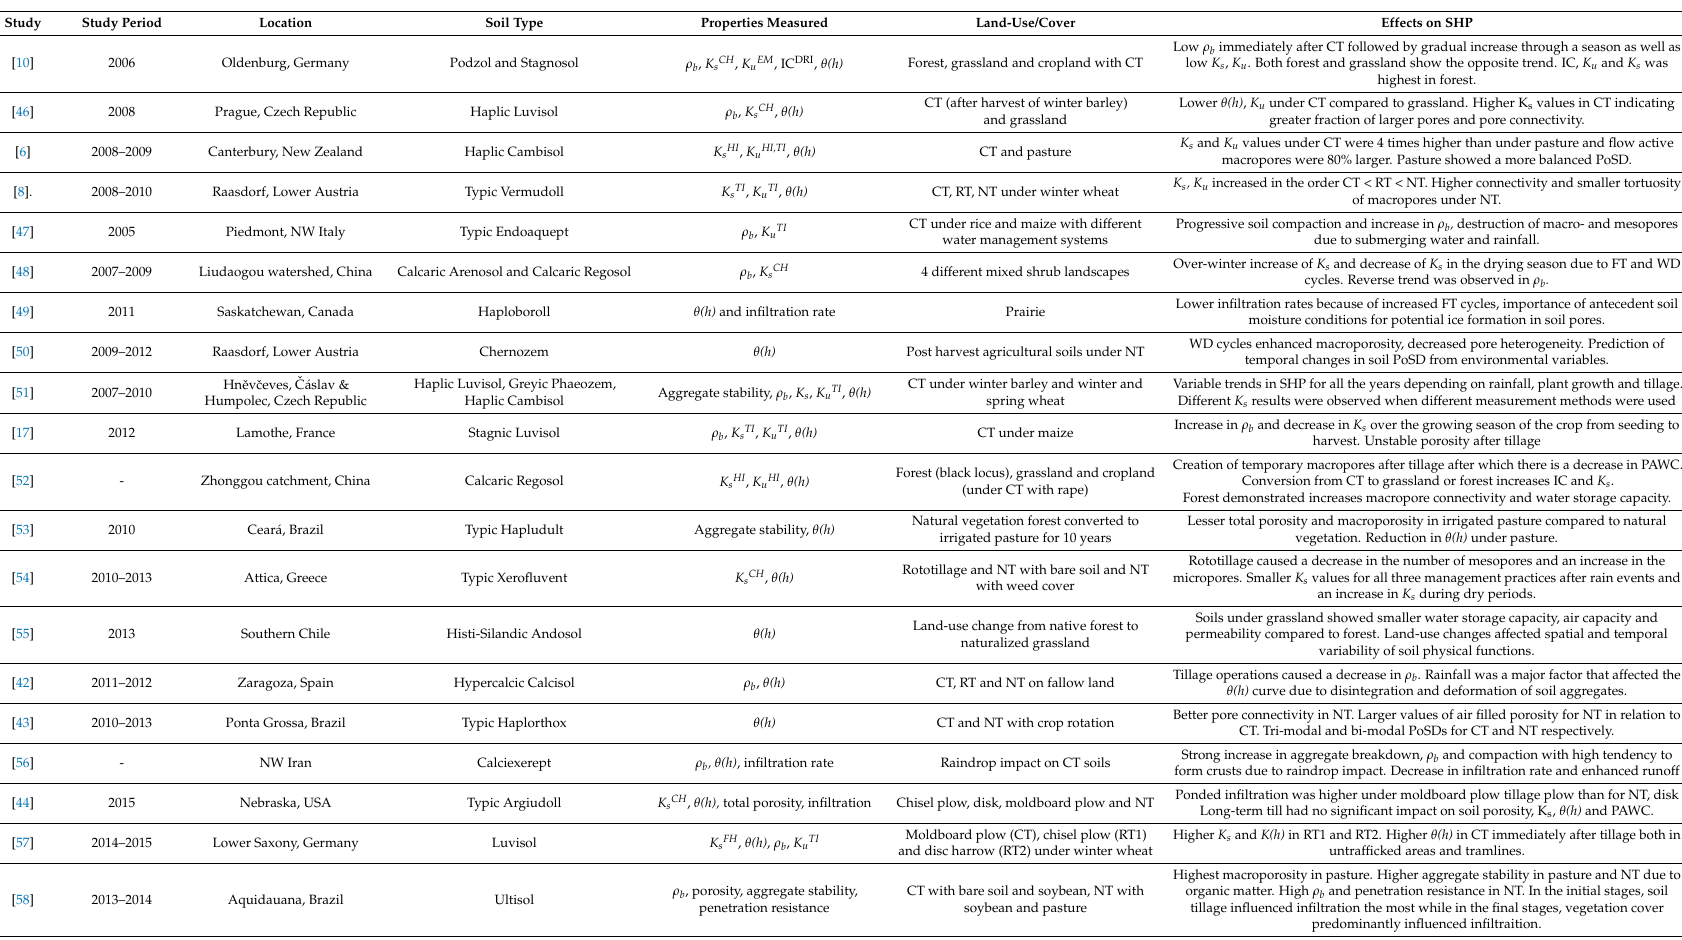
Table 1. Effects on soil hydraulic properties (SHP) due to agricultural management practices and atmospheric impacts published after